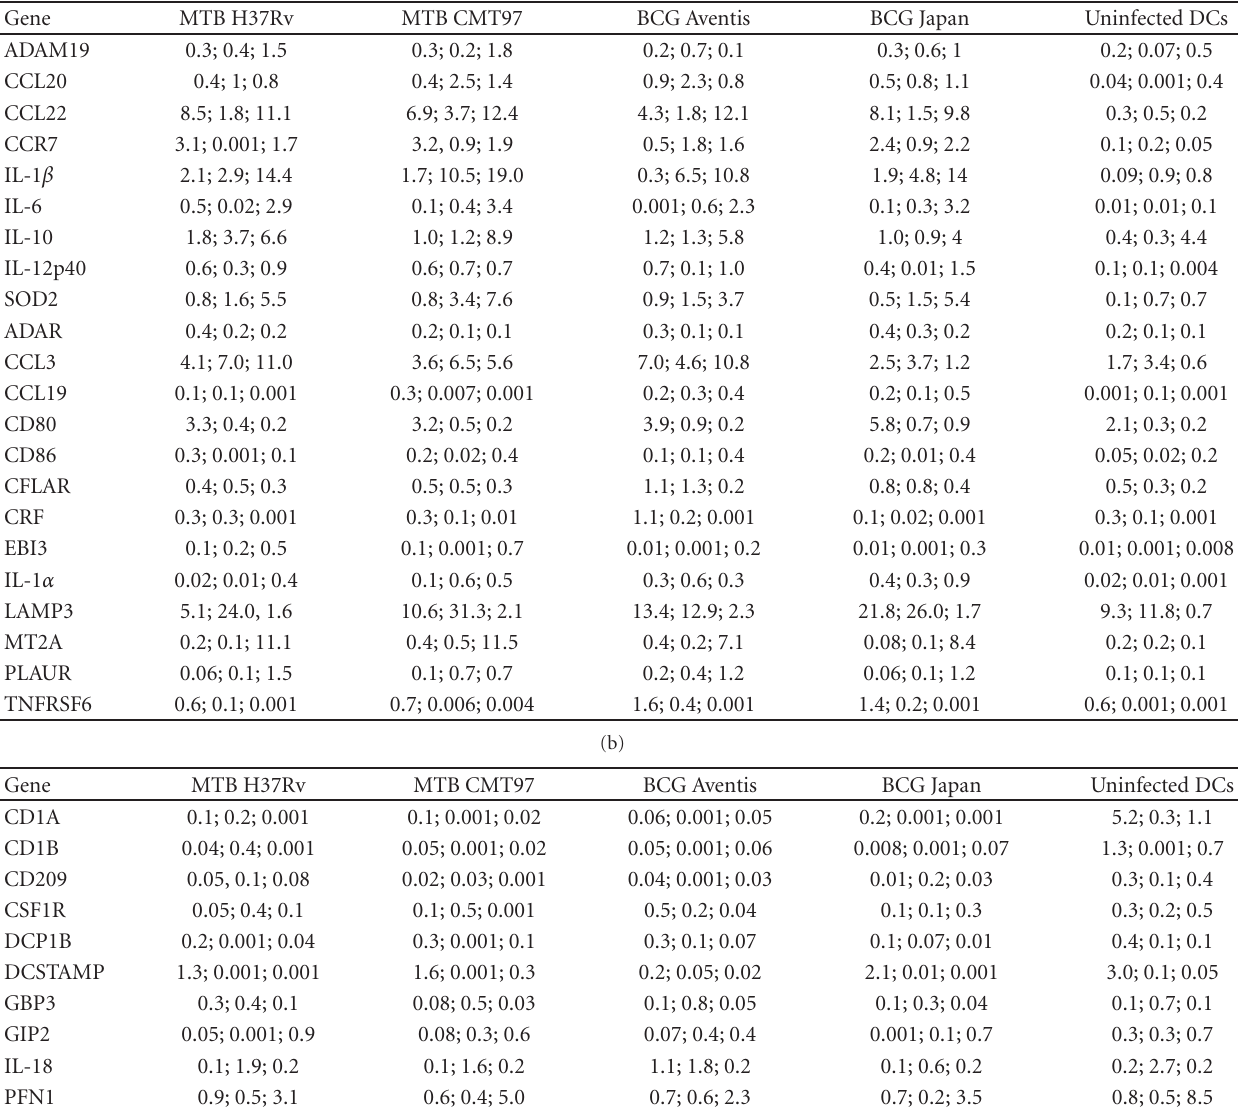
Table 3: (a) nDens of upregulated genes of DCs infected with di ff erent MTB and BCG strains. (b) nDens of downregulated genes of DCs infected with di ff erent MTB and BCG